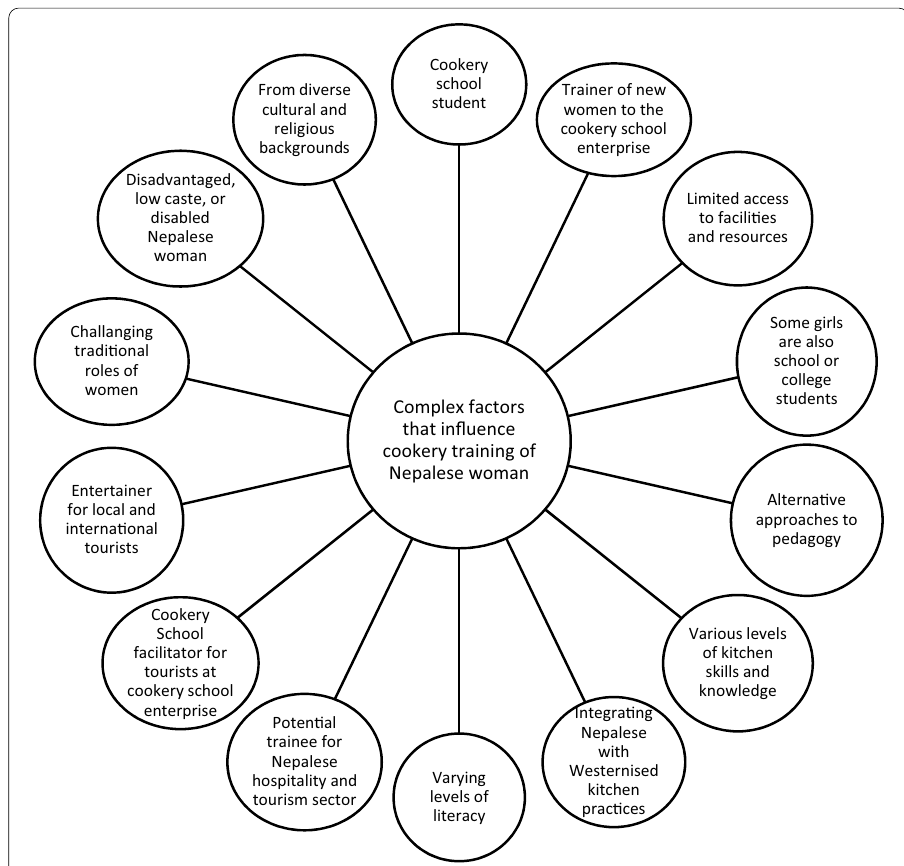
Fig. 1 Visual representation of the complex factors that influence roles, responsibilities and relationships of the Nepalese women participating in the cookery school